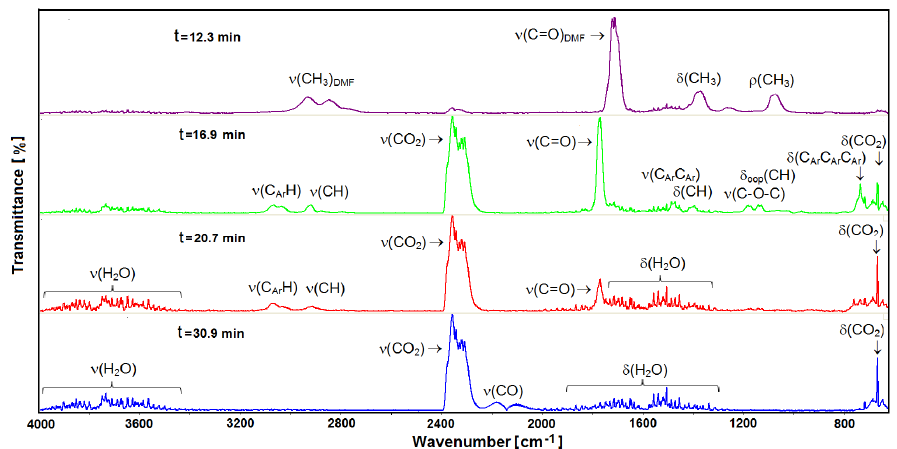
Figure 8. The FTIR spectra of gases evolved at different temperatures for 2 . Complex 2 is stable in nitrogen atmosphere up to 157 ◦ C (6.5 min). At higher tempera- tures, the liberation of DMF molecules from the structure of the metal complex takes place in several overlapping steps in the range of 6.06–16.00 min. The infrared spectra exhibit two distinct medium-strong bands occurring at 2938 and 2848 cm − 1 . These bands derived from the stretching asymmetric ( ν asym ) and symmetric ( ν sym ) vibrations of methyl groups CH 3 from DMF. The presence of a very strong band at 1723 cm − 1 results from the stretching vibration ( ν ) of carbonyl group (C=O) group of DMF. The asymmetric and symmetric bending vibrations ( δ ) of methyl groups (CH 3 ) appear at 1457 and 1374 cm − 1 , respectively. Additionally, the relatively intense bands at 1270 and 1076 cm − 1 can be ascribed to the rocking modes ( (cid:36) ) of methyl bands derived from the gem (CH 3 ) 2 N group of DMF [59,60]. Removal of N , N’ -dimethylformamide molecules is observed up to about 300 ◦ C (13.7 min). At higher temperatures, pyrolysis of the desolvated form of the complex takes place. In the temperature range of 310–400 ◦ C (14–18 min), the intensity of different moieties emanation is the highest. The FTIR spectra show a very strong band consisting of many overlapping peaks in the wavenumber range of 2370–2300 cm − 1 as well as those at 668 cm − 1 due to stretching and deformation vibrations of CO 2 . Apart from carbon dioxide, the analysis of the FTIR spectra allows finding several other volatile compounds such as ortho -xylene, aliphatic ethers, and aliphatic acids. The identification of such compounds was made based on the presence of characteristic bands in the wavenumber ranges: 3100–2800; 1800–1600; 1200–1100; and 780–600 cm − 1 . The weak bands at 3076 and 3038 cm − 1 derived from aromatic C-H stretching vibrations, while maxima at 2938 and 2848 cm − 1 can be